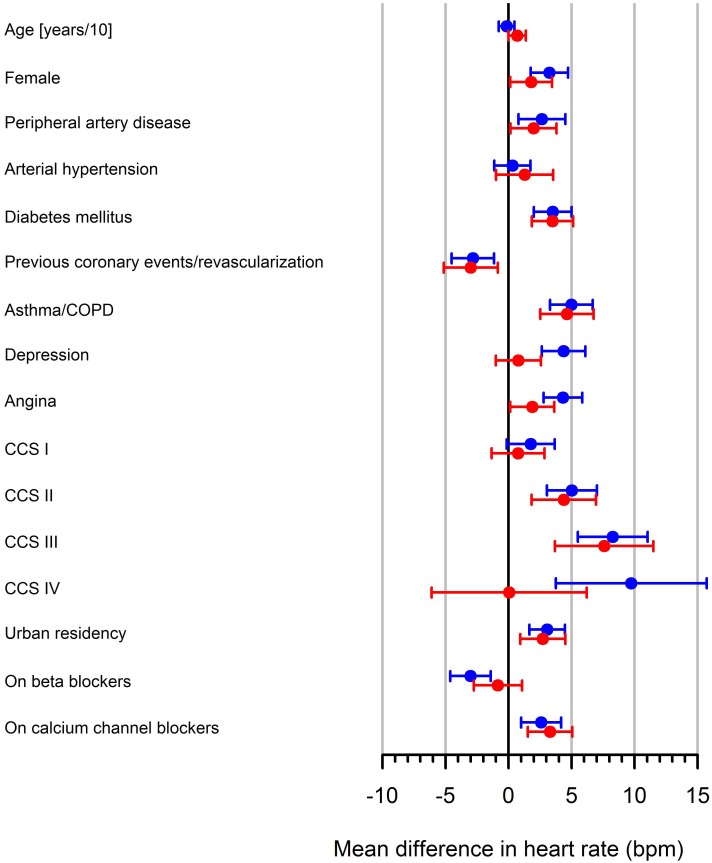
Regression estimates and confidence intervals of simple models analyzing predictors of heart rate in ProCor I (blue) and ProCor II (red).The effect of age is shown in HR change per 10 years. Female denotes female gender.